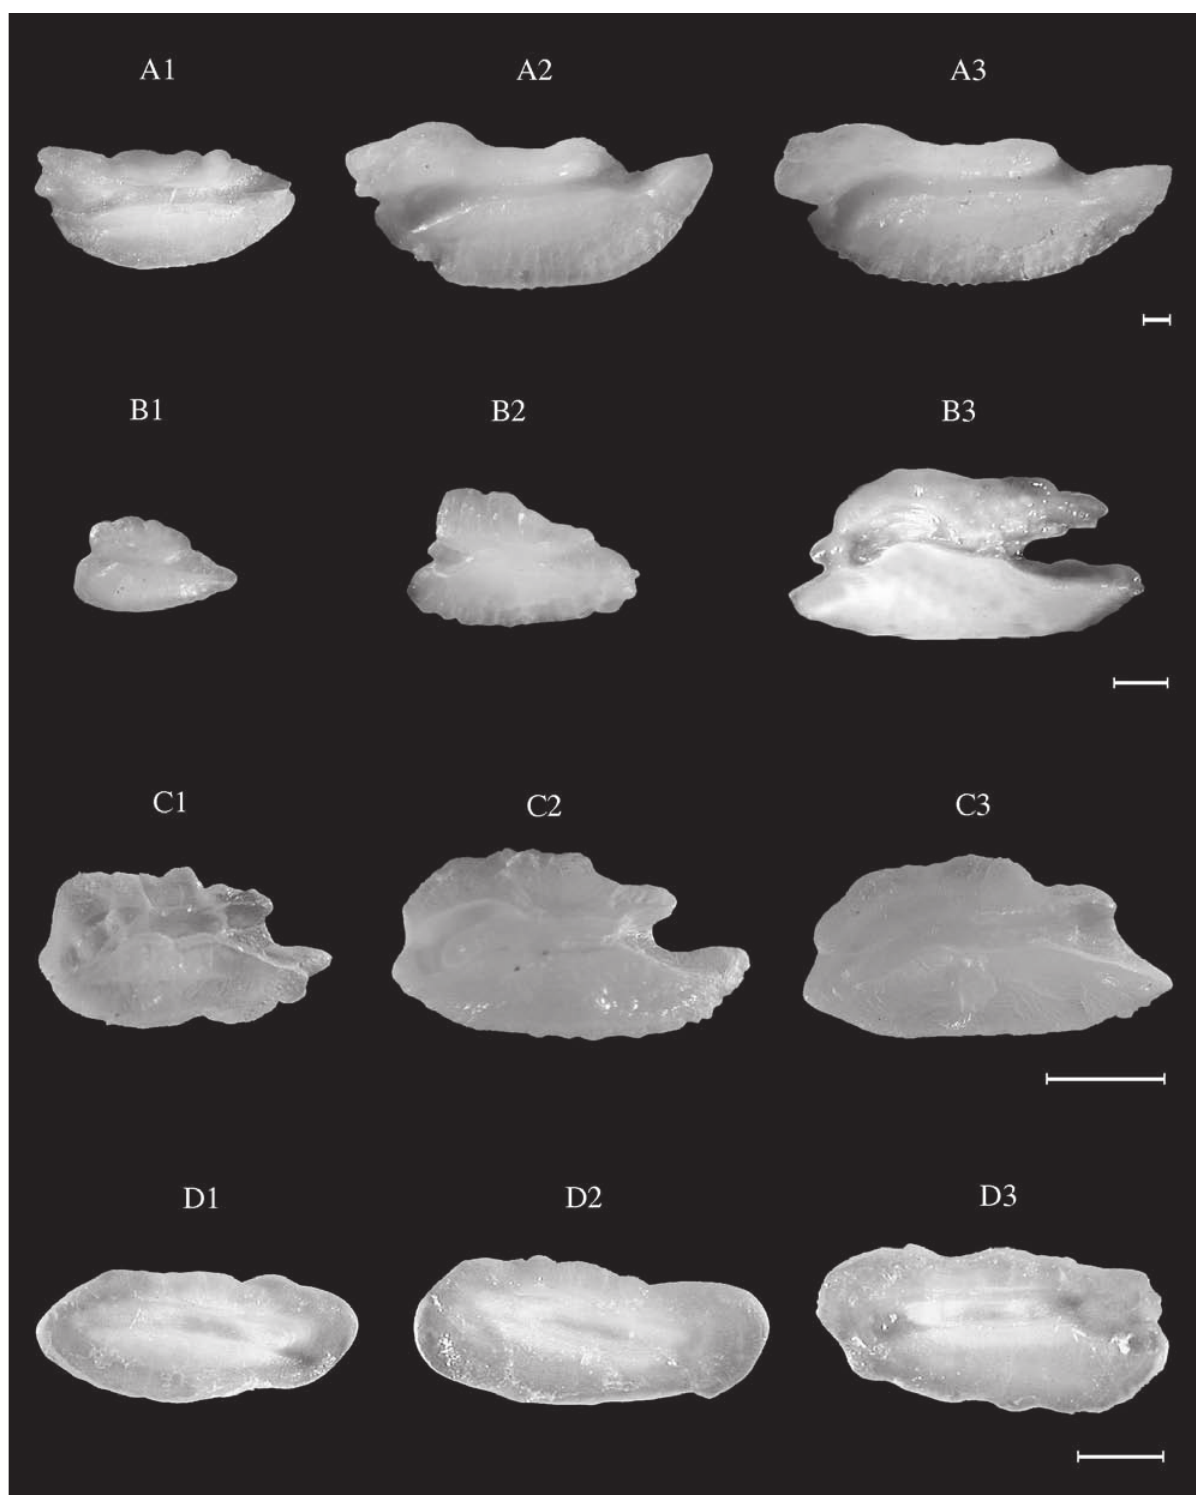
Fig. 20. – Aulopus filametosus . TL: A1, 21.0 cm (WM); A2, 34.0 cm (CEA); A3, 42.3 cm (CEA). Synodus saurus . TL: B1, 18.2 cm (CEA); B2, 31.9 cm (CEA); B3, 42.0 cm (WM). Synodus synodus (CEA). TL: C1, 19.7 cm; C2, 22.3 cm; C3, 22.5 cm. Chlorophthalmus agassizi (WM). TL: D1, 8.0 cm; D2, 9.0 cm; D3, 13.5 cm. Scale bar = 1